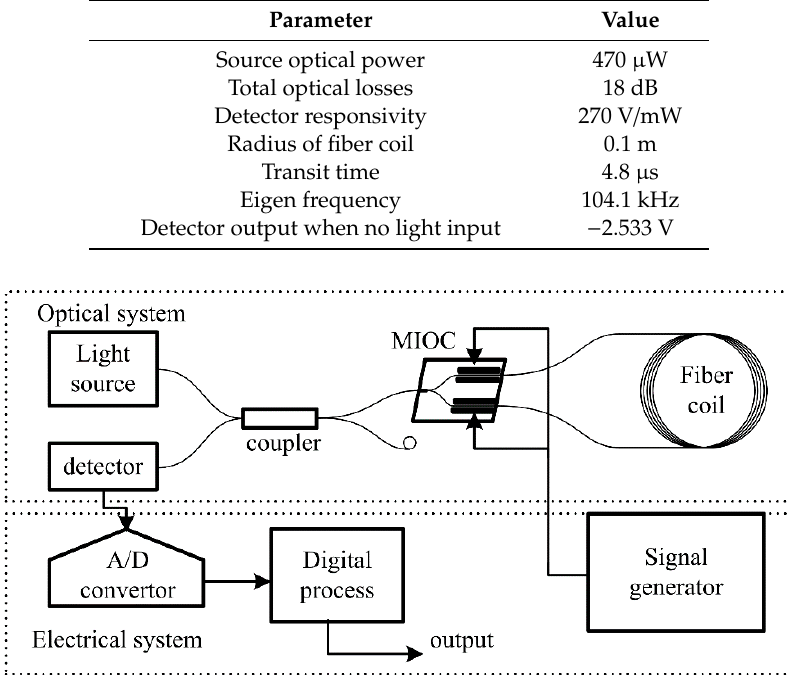
Figure 5. Schematic of the Sagnac interferometer.